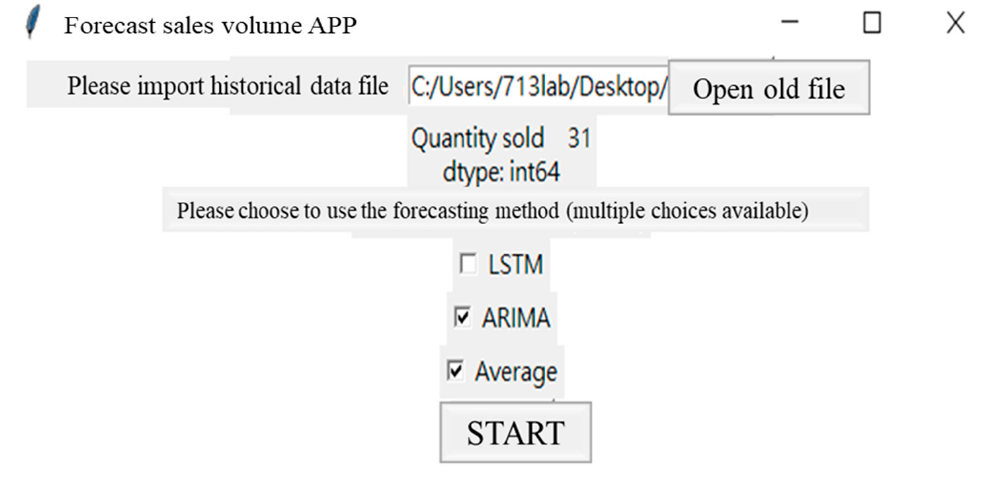
Figure 8. Method filters the schematic.